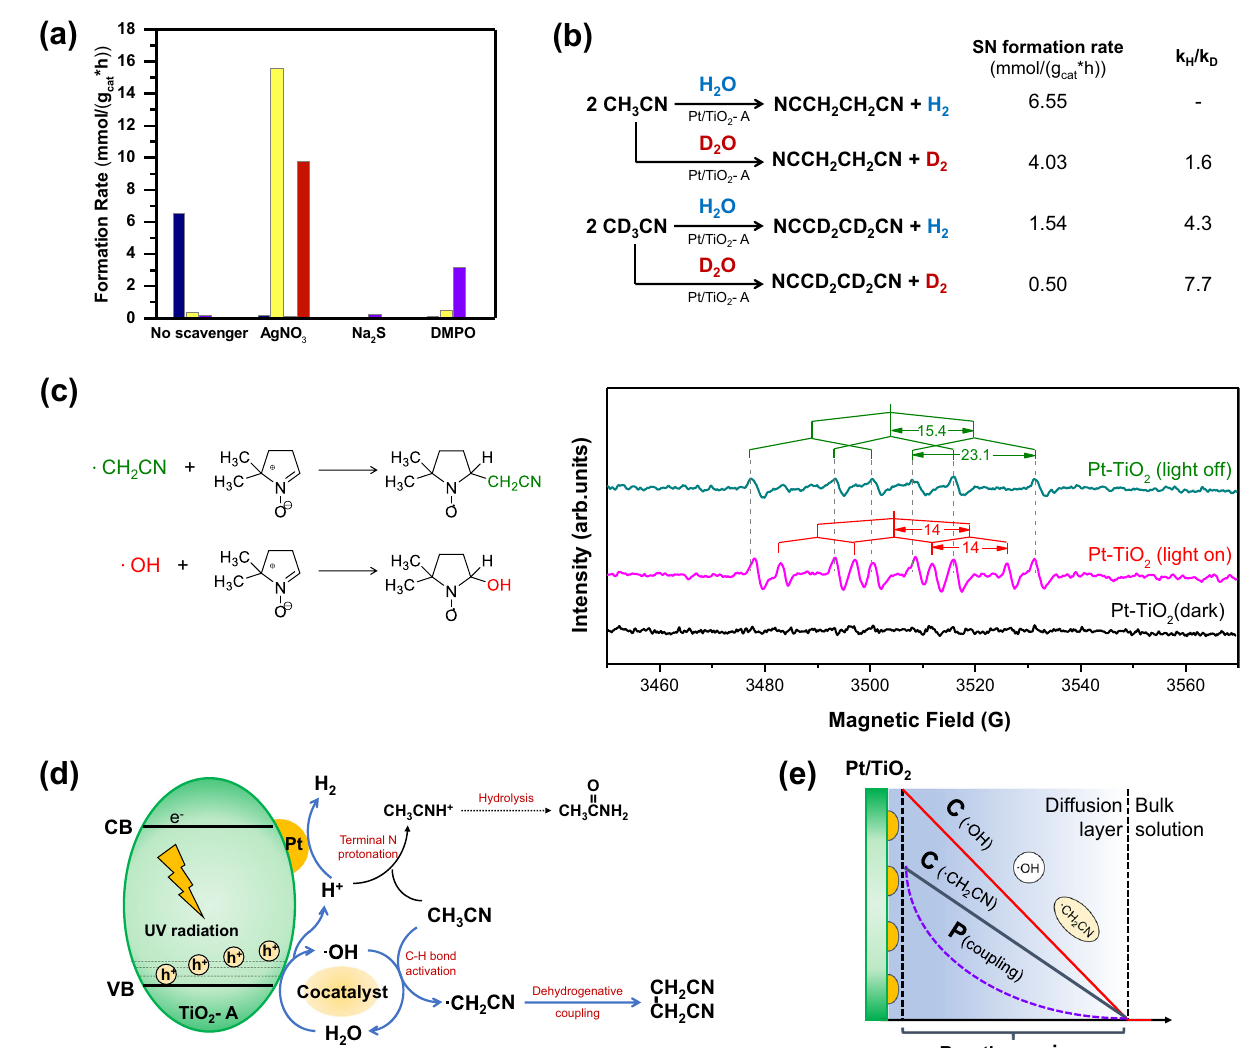
Fig. 4 | Mechanism study of CH 3 CN dehydrogenative coupling over Pt/TiO 2 -A catalyst. a Control experiments of CH 3 CN coupling reaction in the presence of electron, hole and radical scavengers; ( b ) determination of C-H(D) and O-H(D) kinetic isotope effect using D 2 O and CD 3 CN as substitution reagents; ( c ) EPR